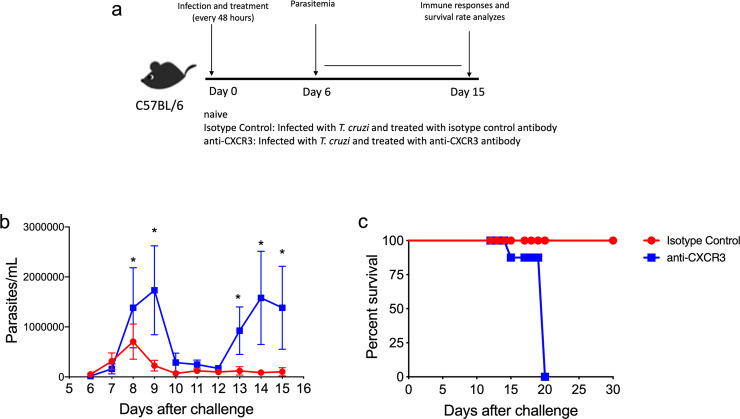
CXCR3 receptor is important to parasitemia and survival of C57BL/6 infected with Trypanosoma cruzi.a-Experimental scheme showing the model used in this study. Both Isotype control and anti-CXCR3 antibody treated groups were infected with 1x104 blood trypomastigotes of the Y strain of T. cruzi. On the same day of infection, anti-CXCR3 group was treated with 250 μg of anti-CXCR3 antibody while the isotype control group was treated with the same concentration of anti-IgG of Rat antibody. The treatment was performed every 48 hours until 15 days after infection by intraperitoneal route. b-Graph of parasitemia showed in linear scale of Isotype Control and anti-CXCR3 groups. c-The Kaplan–Meier curves for survival of Isotype control and anti-CXCR3 groups. The statistical differences between the groups were compared using the log-rank test (p = 0.0091). Data are mean ± SD and are representative of 3 independent experiments with n = 4. *values are significantly different between isotype Control and anti-CXCR3 groups in indicated days (*p>0.001). The statistical analysis was performed using the Student’s t-test.